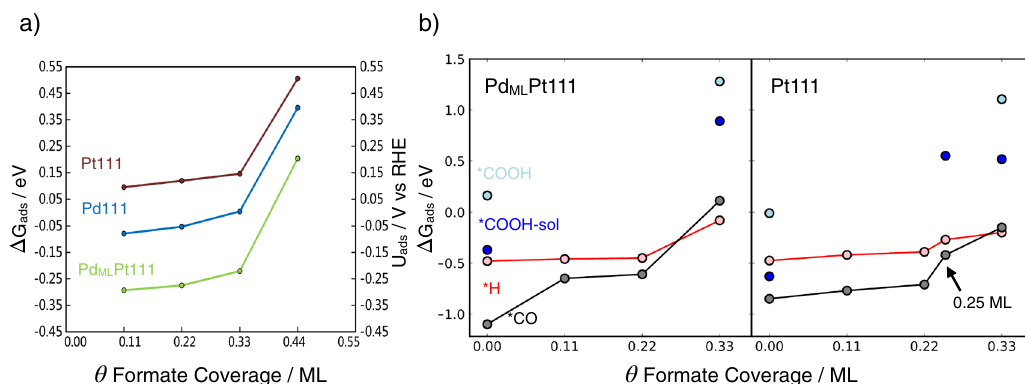
Fig. 5 Adsorption energies and potentials of adsorbates. a Adsorption/formation energies (left y -axis) and corresponding adsorption potentials (right y -axis) for adsorbed formate from formic acid in solution as a function of coverage, on Pd ML Pt(111) (green), Pd(111) (blue), and Pt(111) (red). b Free energy of adsorption of *H, *CO, and *COOH corresponding to 1/9 ML at 0 V vs RHE, for Pd ML Pt(111) and Pt(111), as a function of different coverages of co- adsorbed formate from 0.11 to 0.33 ML also including 0.25 ML for Pt(111) as speci fi ed with the arrow, because this is the experimentally observed maximum coverage on Pt(111). Only the low and higher coverages for *COOH are shown (0.11 ML and 0.33 ML), where *COOH-sol (blue) is with solvation and *COOH (light blue) is without. Connecting lines are only intended as a guide for the